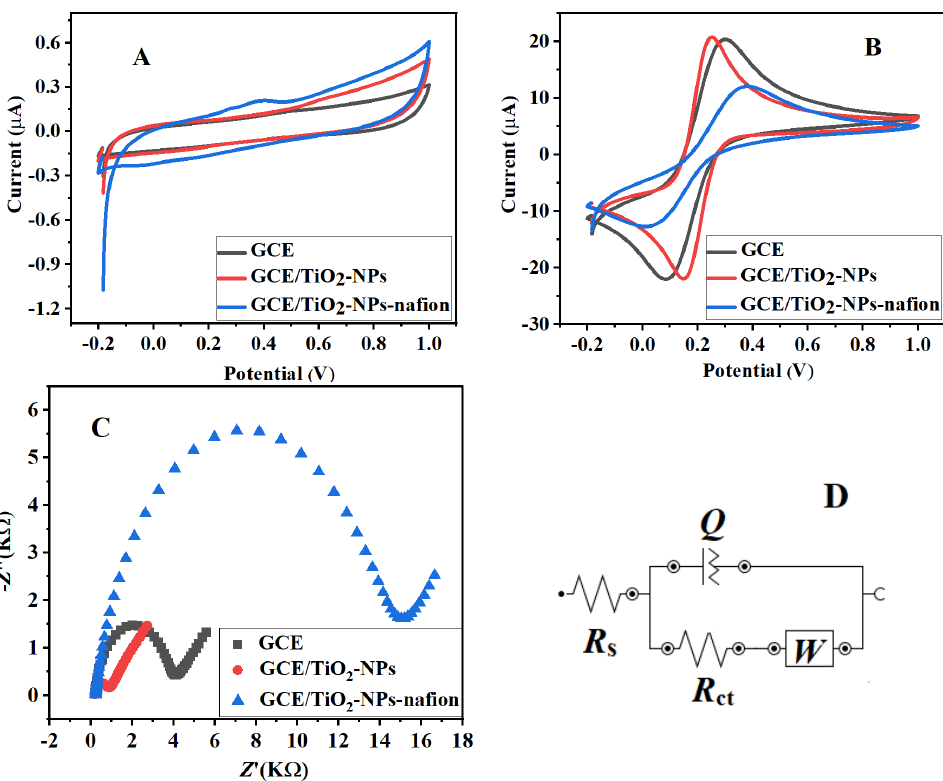
Figure 4. CVs obtained in ( A ) 0.1 M PBS and ( B ) in 0.1 M PBS at pH 7 containing 5 mM of [Fe (CN) 6 ] 3−/4− at 25 mV/s scan rate, ( C ) Nyquist plots in 5 mM redox probe at the unmodified and modified electrodes, and ( D ) Modelled electric circuit diagram for the electrodes. Table 2. Summary of CV parameters recorded for the bare and modified electrodes in 5 mM [Fe (CN) 6 ] 3−/4− .